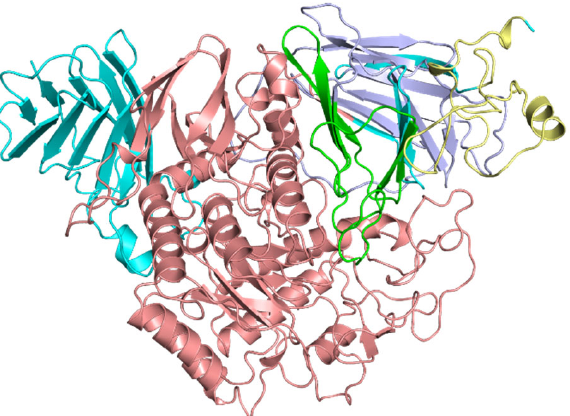
Figure 3. Three-dimensional structure of the target protein Alpha Glucosidase enzyme. P Terfoil domain (TFF) (2–56) is represented in pale-yellow color, Gal_mutarotase_N (69–176) in light blue,